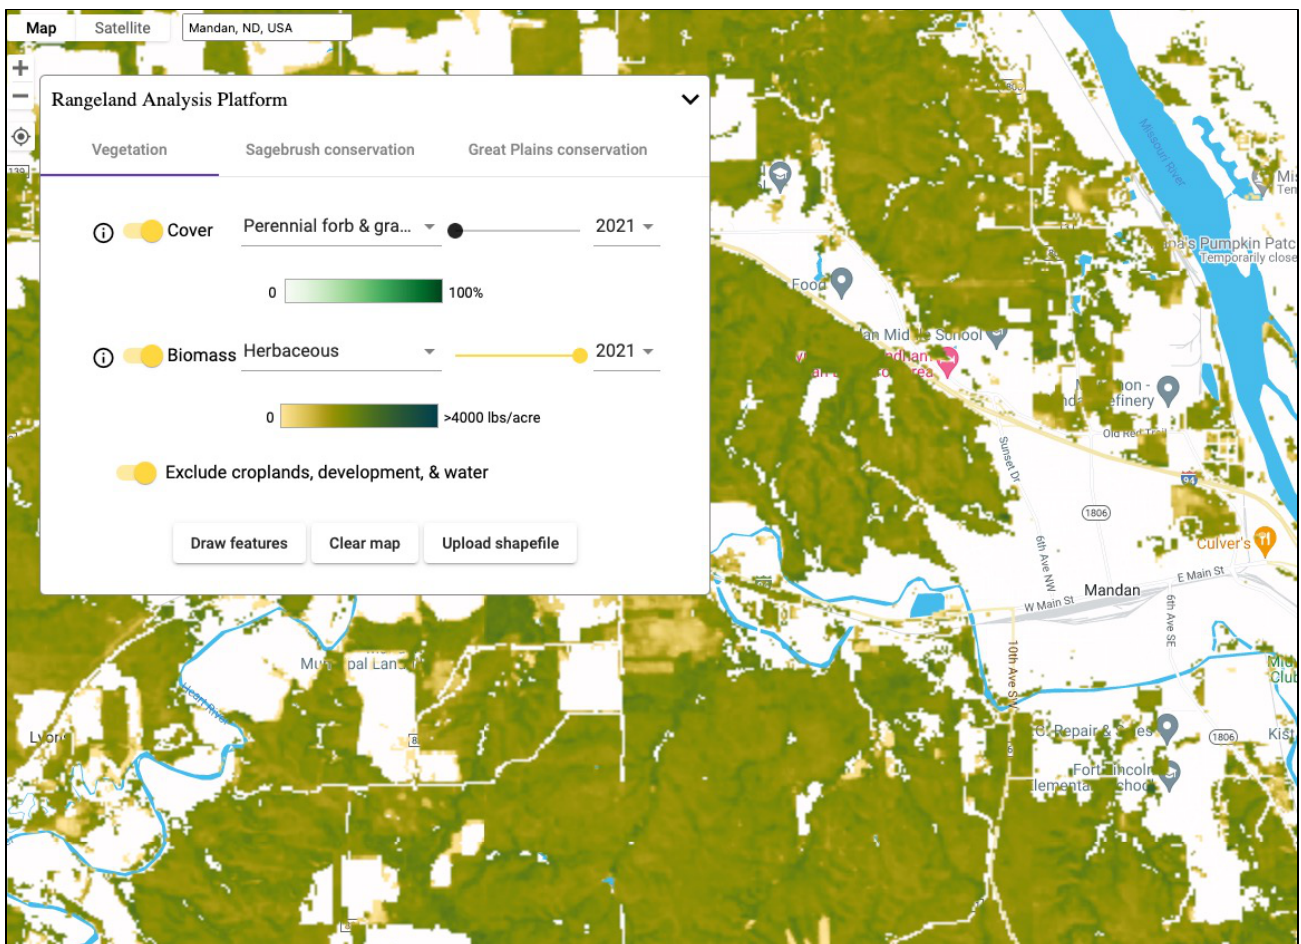
Figure 9. Range analysis platform, interactive web-based tool for forbs and grass percentage cover and herbaceous biomass